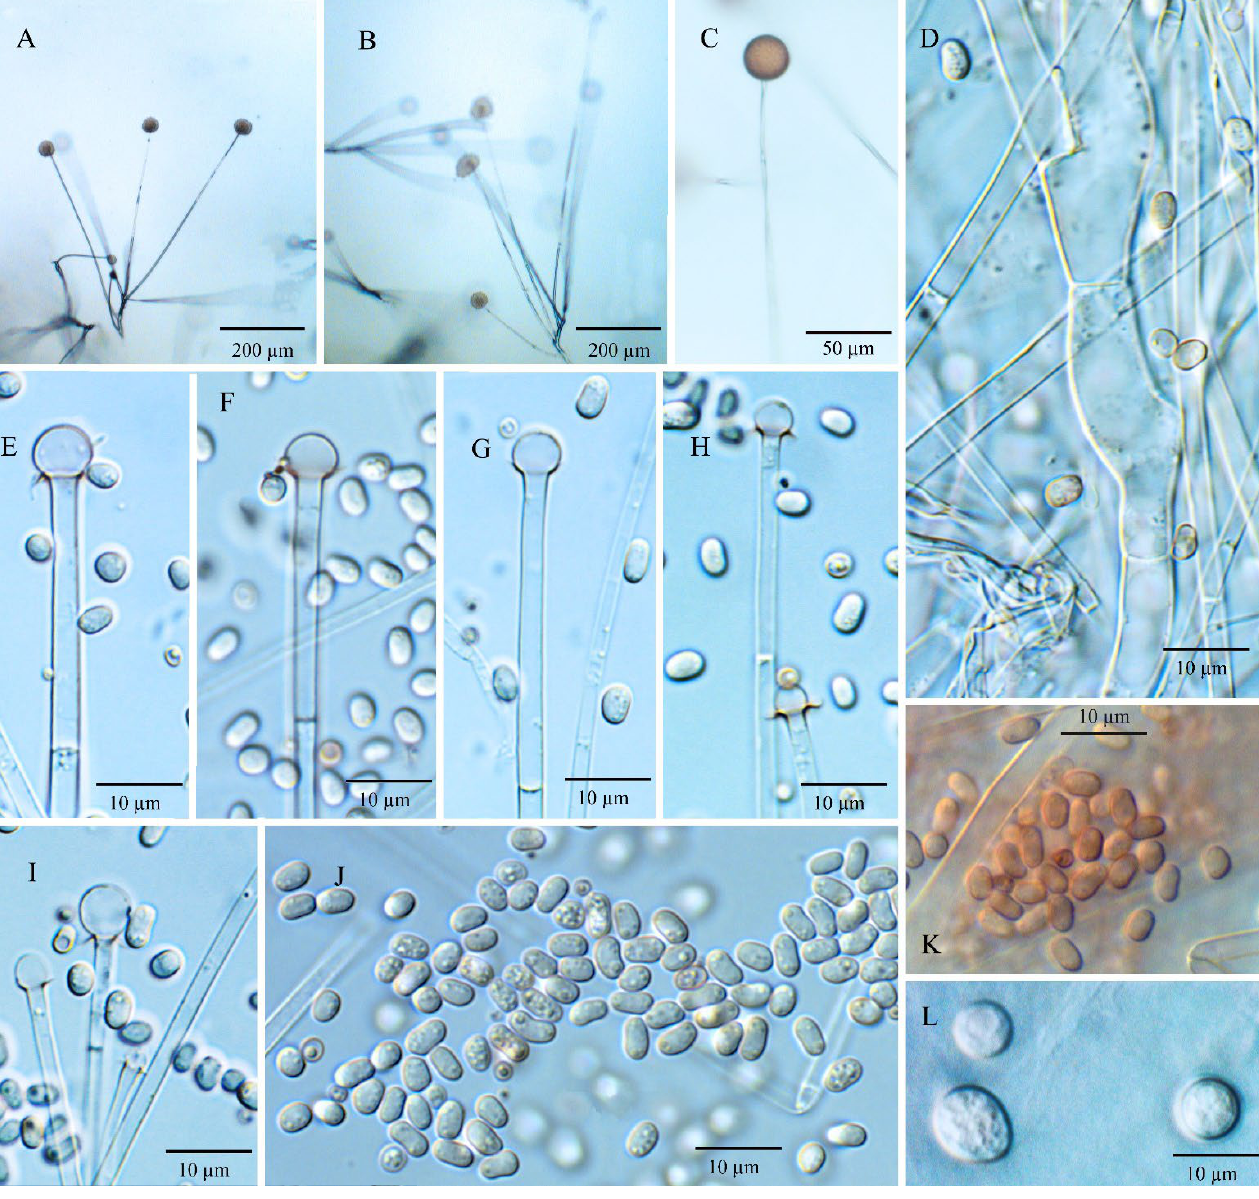
Figure 4. Umbelopsis macrospora . ( A , B ) Branched sporangiophores. ( C ) Sporangium at tip of spo- rangiophore. ( D ) Branch point of sporangiophore. ( E – I ) Various shapes of collars and columellae at sporangiophore tips after the sporangia have been dissolved. ( J , K ) Sporangiospores. ( L ) Micro- chlamydospores.